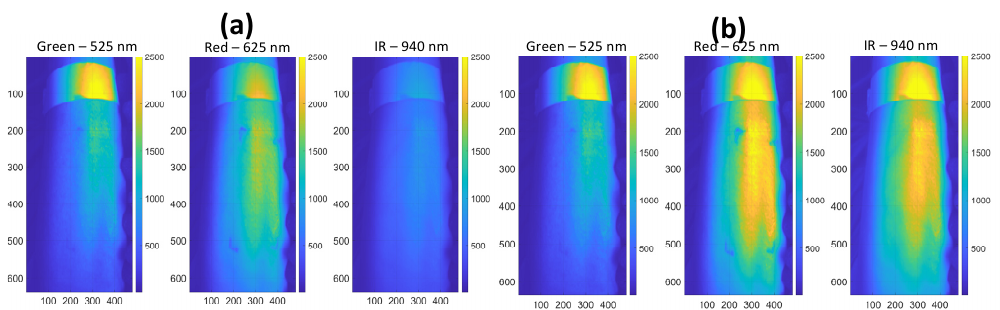
Figure 20. Amplitude DC maps, 3- λ mode: ( a ) before calibration; ( b ) after calibration.